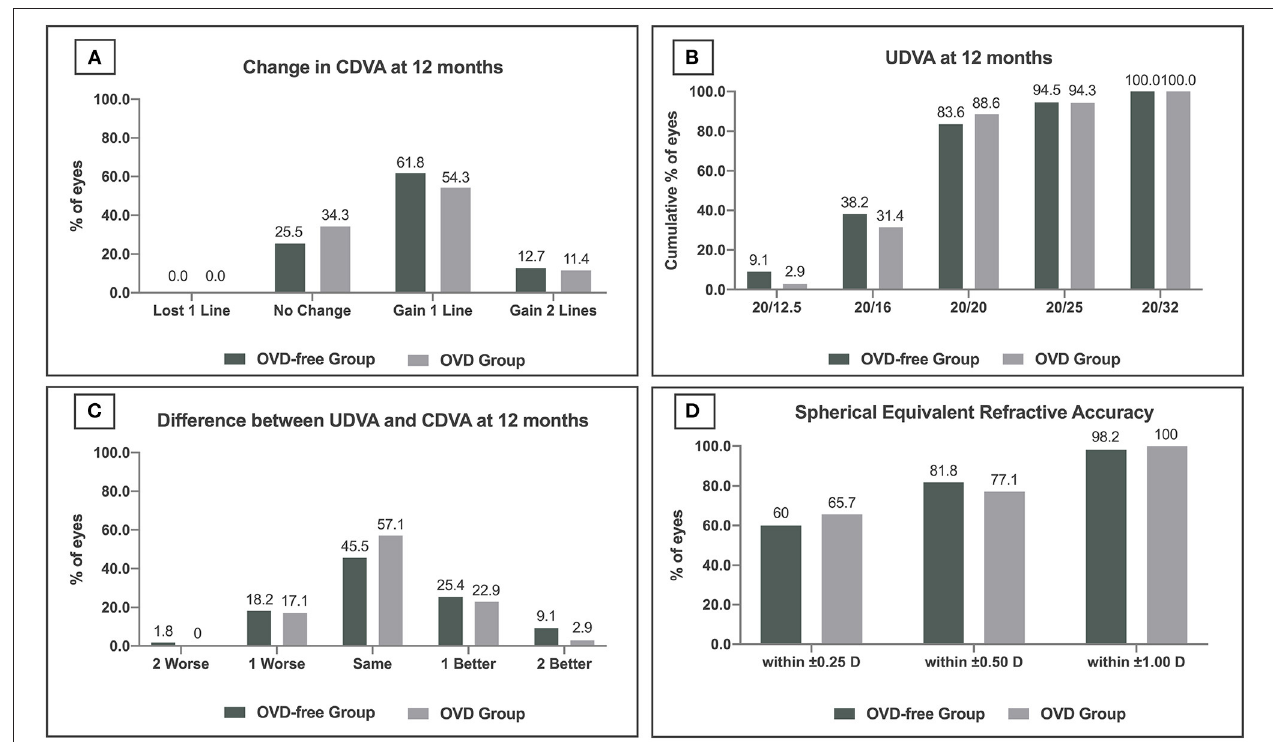
FIGURE 2 | Refractive outcomes at 12 months after the Implantable Collamer Lens V4c implantation in ophthalmic viscosurgical device-free (OVD-free)/OVD group. (A) Change in corrected distance visual acuity (CDVA). (B) Uncorrected distance visual acuity (UDVA). (C) Difference between postoperative UDVA and preoperative CDVA. (D) Spherical equivalent refractive